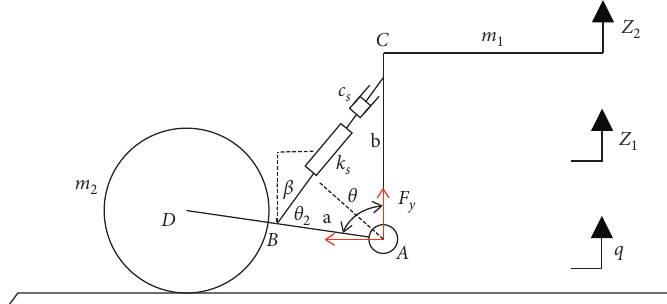
Figure 7: Quarter suspension dynamics model of the testing platform vehicle. Table 1: Structural parameters of the testing platform vehicle.